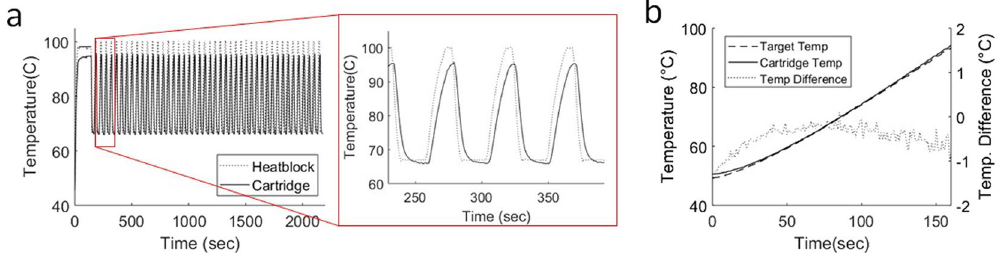
Figure 3. PCR temperature consistency. ( a ) Thermal cycling profile as measured by thermistors within the heat block (dashed line) and embedded within a test cartridge PCR well (solid line). PCR assays demonstrated here used a 2-minute hot-start at 95 °C followed by 45 cycles of 20 seconds at 65 °C anneal and 5 seconds at 95 °C denature. ( b ) Temperature ramp profile demonstrating close agreement between the targeted temperature with the actual measured temperature in the cartridge with error measuring < 1 °C throughout the relevant range of temperatures for melt analysis of amplified nucleic acid products.